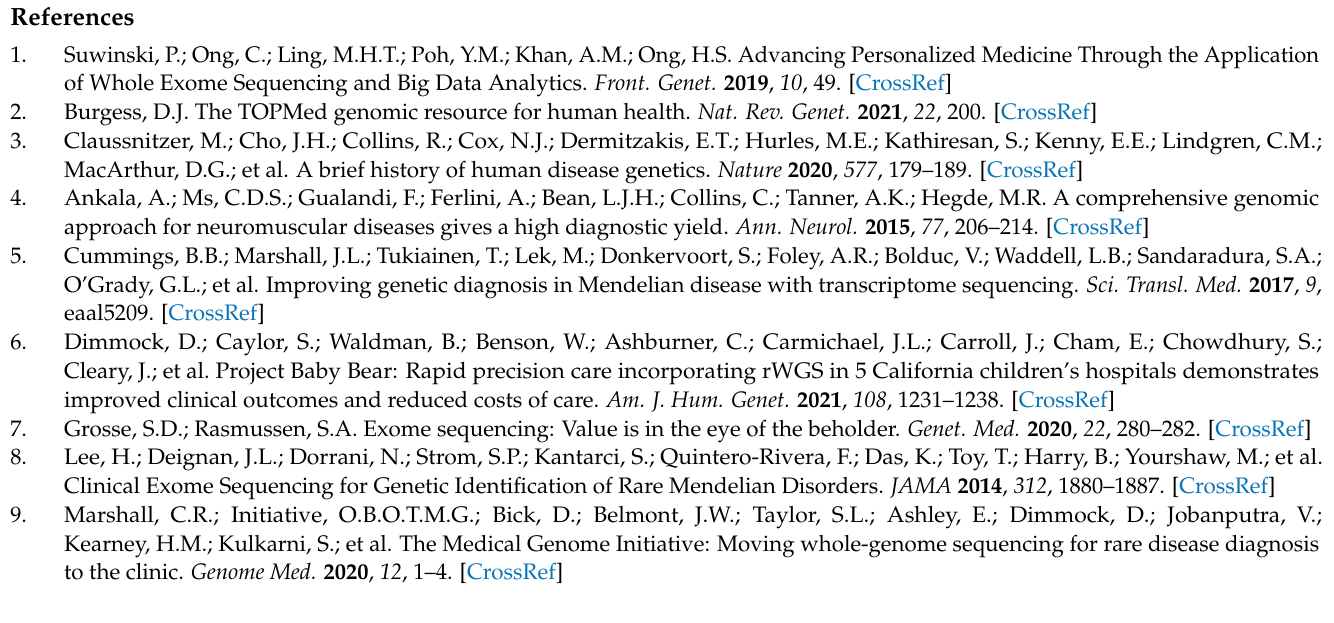
Figure S1: XIAP protein expression, measured by flow cytometry, is reduced in sample